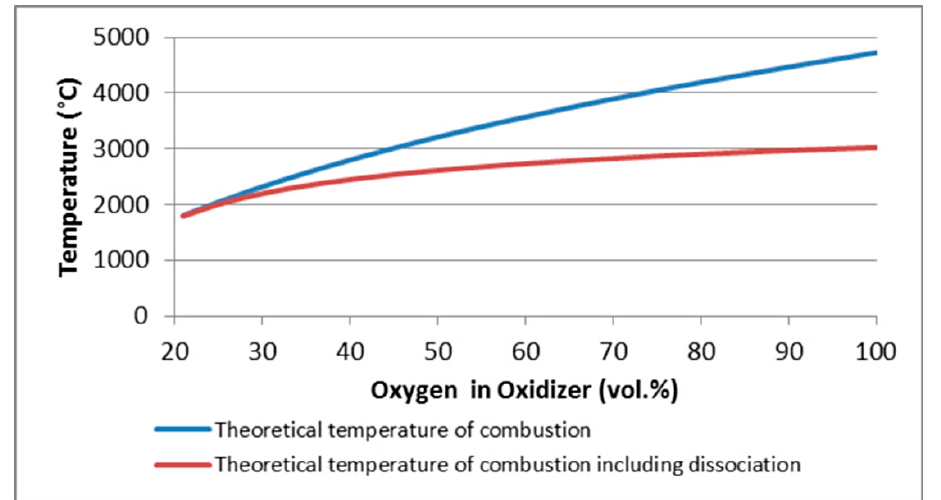
Figure 6. Dependence of temperature as a function of oxygen concentration in the oxidizer ( m = 1.2) (mathematical modeling).